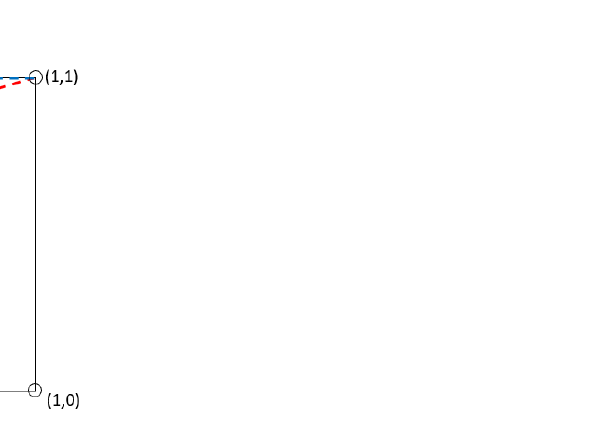
Figure 6. Example of minimizing the distance from maximum theoretical threshold value of point A to any point on the classifier’s ROC.